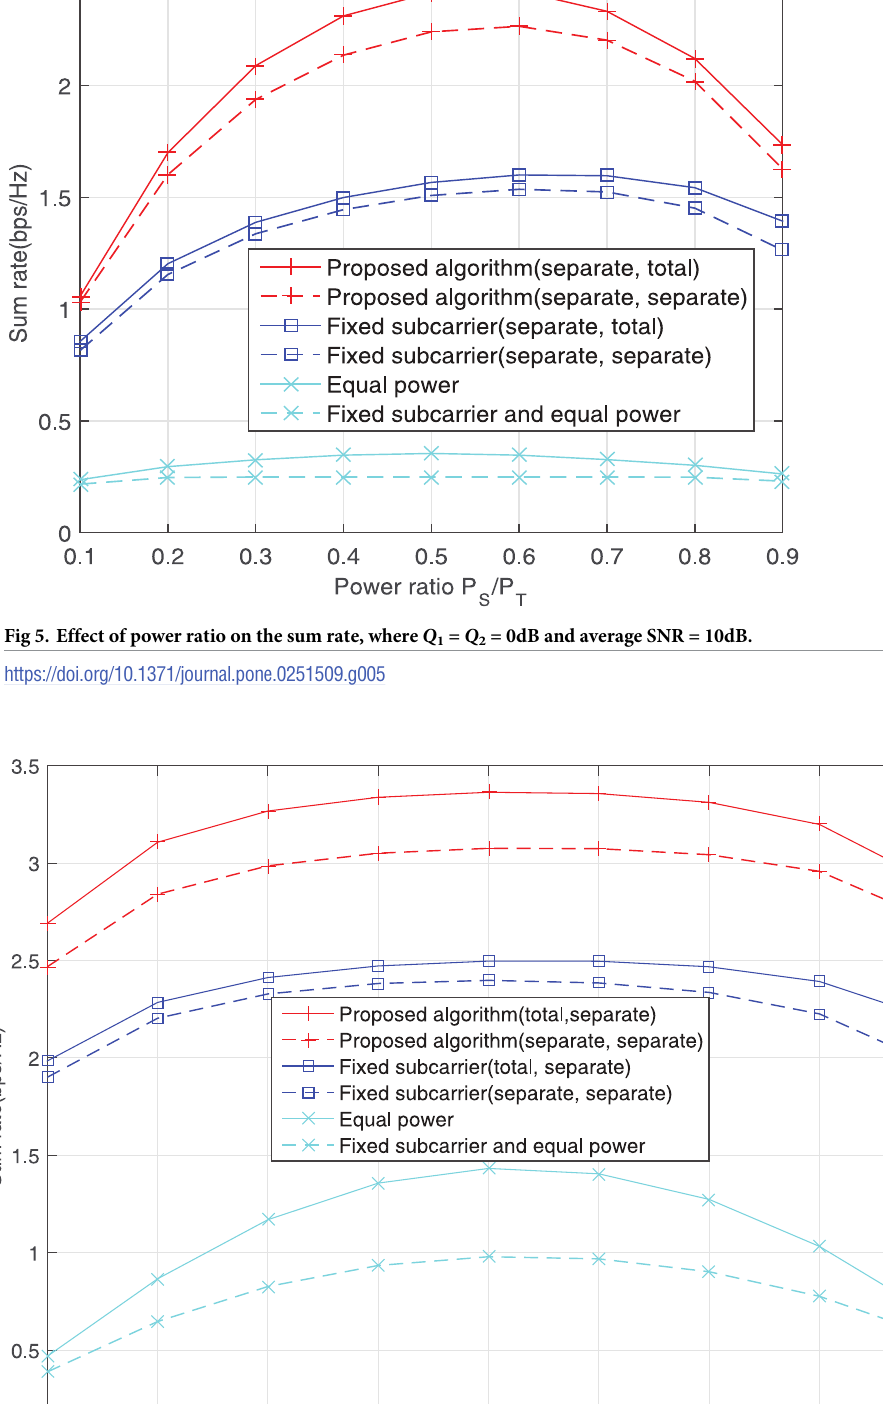
PLOS ONE | https://doi.org/10.1371/journal.pone.0251509 May 13,